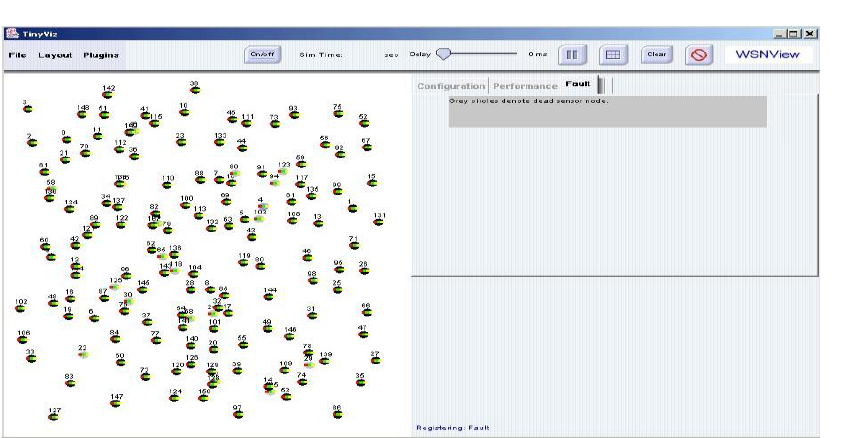
Figure 9. Display after Sensor Nodes Run Out of their Power.